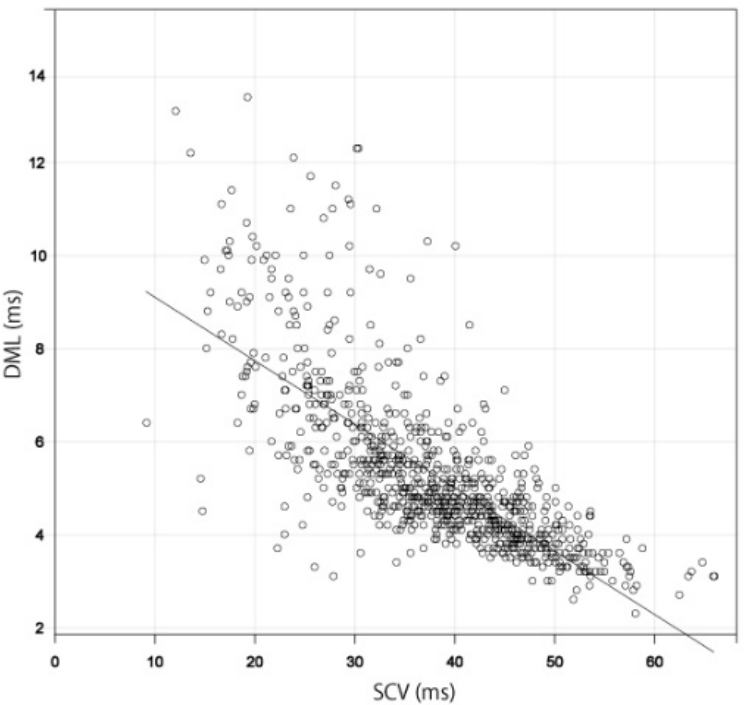
Figure 2. Scatter diagram between SCV and DML. The straight line shows the correlation between SCV and DML. Abbreviations: DML, distal motor latency; SCV, sensory nerve conduction velocity.